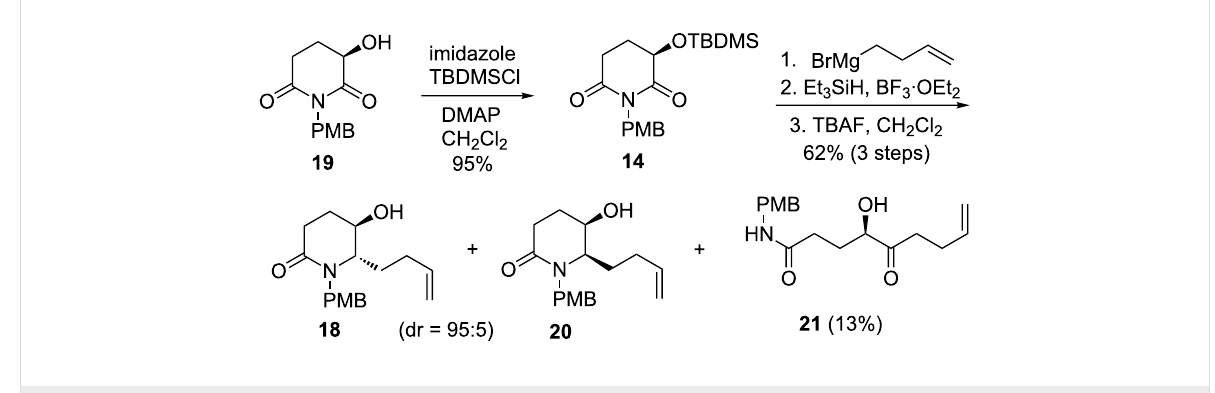
Scheme 7: Synthesis of hydroxylactam 18 .